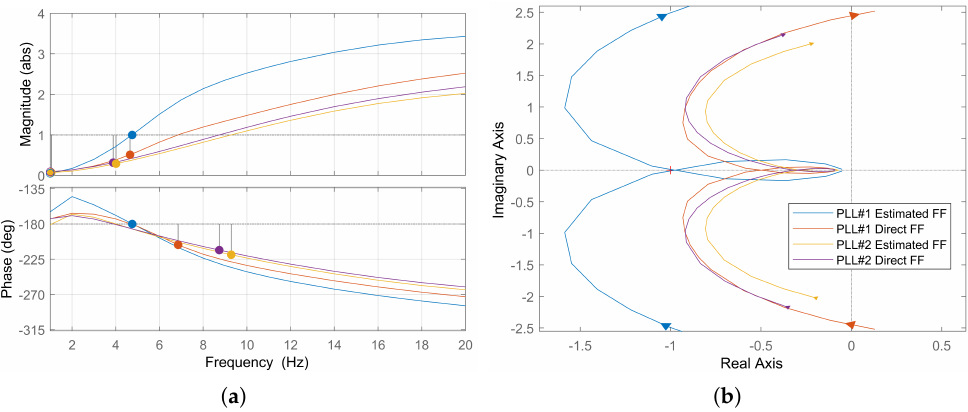
Figure 25. System eigenvalue λ 1 . Influence of the PLL and the feedforward. ( a ) Bode diagram, ( b ) Nyquist